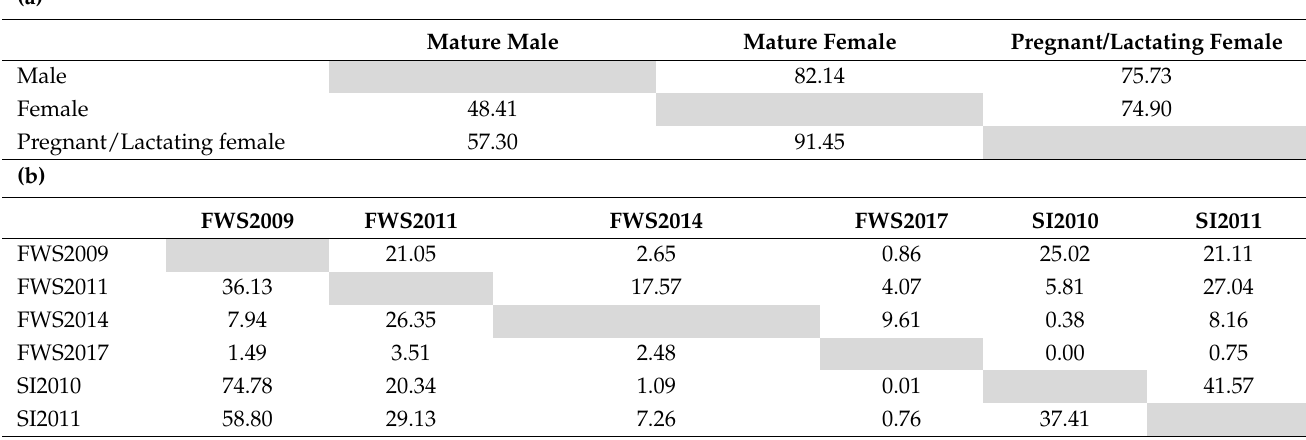
Table 5. Confusion matrices of triple isotope ( δ 13 C, δ 15 N and δ 34 S) niche overlap at the 95% confidence level of mature long-finned pilot whales ( Globicephala melas edwardii ) processed from stranding events on the New Zealand coast between 2009 and 2017. Values are the chances (%) that an individual from the group on the left-hand column would be found within isotope niche of any of the other groups in its row. Data presented by ( a ) maturity status and ( b ) stranding